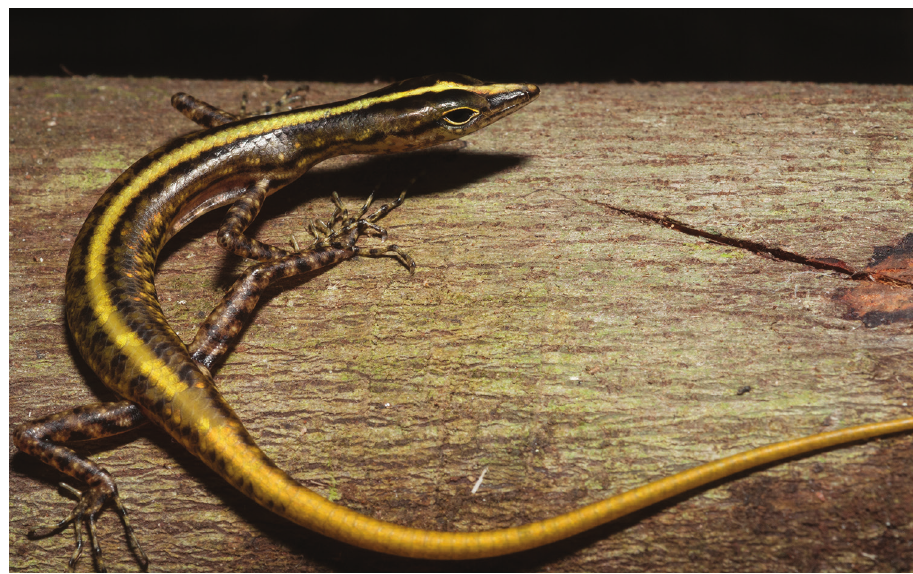
Figure 56. Lipinia pulchella pulchella has been recorded in Agusan del Norte and Agusan del Sur Provinces. Photo: RMB (from the Municipality of Burauen, Leyte Island; specimen deposited at